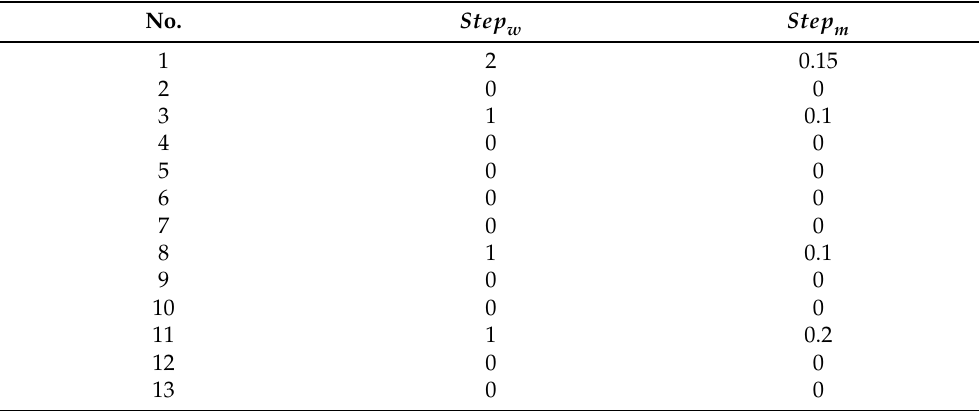
Table 1. The relative searching steps of the actual path to the ideal path at each test point. No. Step